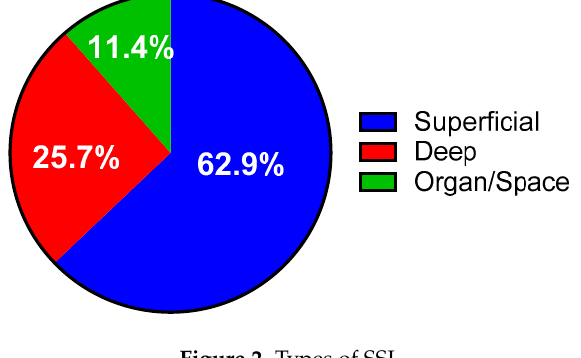
Figure 2. Types of Figure 2. Types of SSI. Figure 2. Types of SSI.